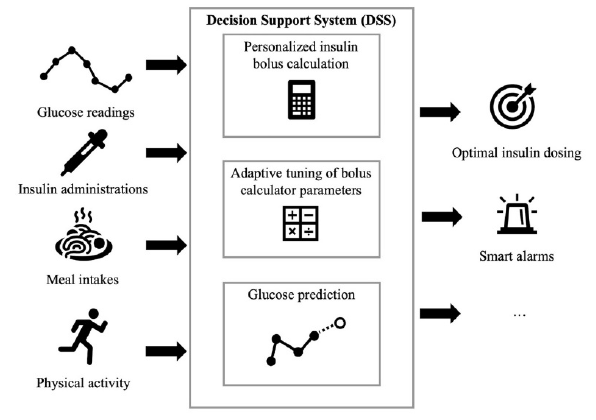
Figure 1. A general structure of a DSS for patient use. By using information on glucose concentration, insulin administrations, meal intakes and physical activity, a DSS provides recommendations on optimal insulin dosage and several other useful features to help patient in managing diabetes. A DSS usually implements three modules: Personalized insulin bolus calculation (Section 3), adaptive tuning of bolus calculator parameters (Section 4) and glucose prediction (Section